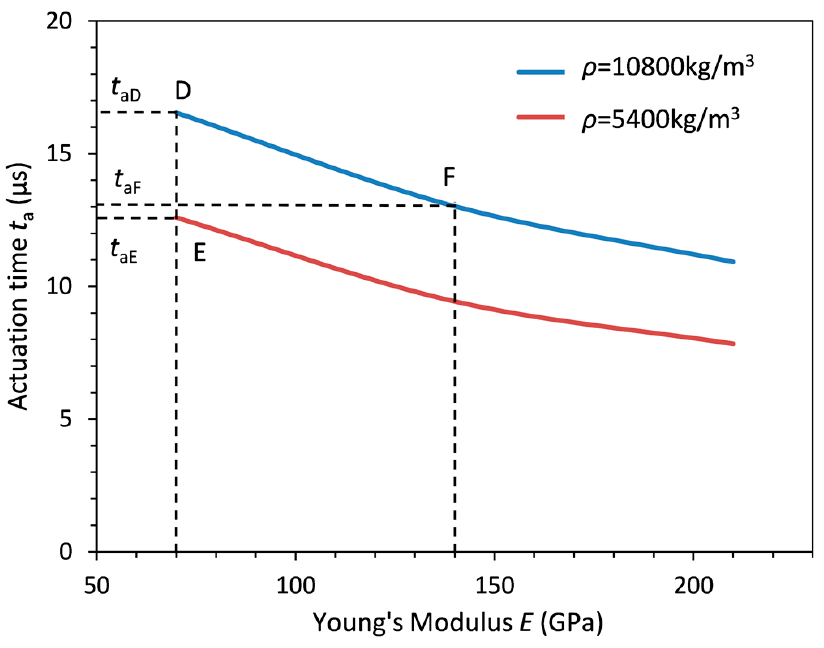
Figure 15. Variation of the actuation time t a with mass density ρ and E for MEMS cantilevers (artificial materials).